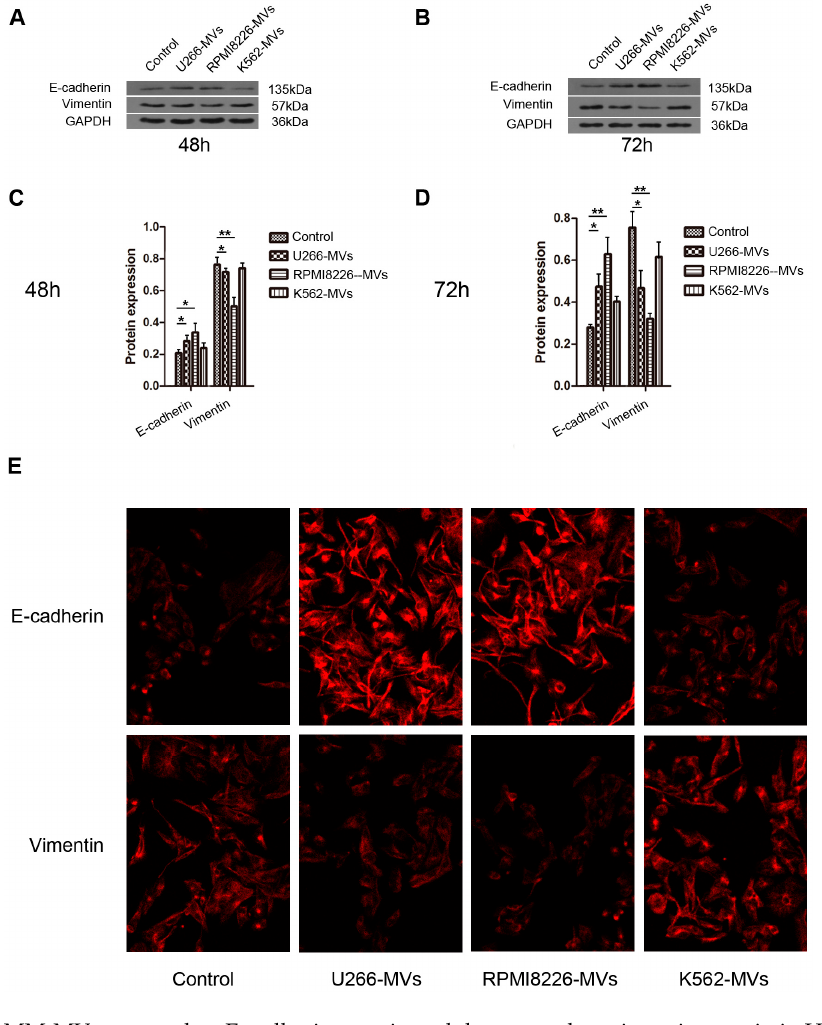
Figure 4. MM-MVs up-regulate E-cadherin protein and down-regulate vimentin protein in HK-2 cells. HK-2 cells were treated with MM-MVs and K562-MVs (10 µ g/mL) and the expression of proteins was assayed using Western blot and immnofluorescence analysis. MM-MVs, but not K562-MVs, significantly up-regulated E-caderin protein and down-regulated vimentin protein in the HK-2 cells at 48 ( A ) and 72 h ( B ). Bar graphs for A and B were shown in ( C ) and ( D ), respectively. The two EMT markers were also assayed using a Nikon (Melvile, NY, USA) Eclipse TE300 fluorescence microscope in the HK-2 cells treated with MM-MVs and K562-MVs (10 µ g/mL) for 72 h ( E ) magnification, 200 × . Each value was expressed as the mean ± SD of three independent experiments. * p < 0.05, ** p < 0.01 vs. control.